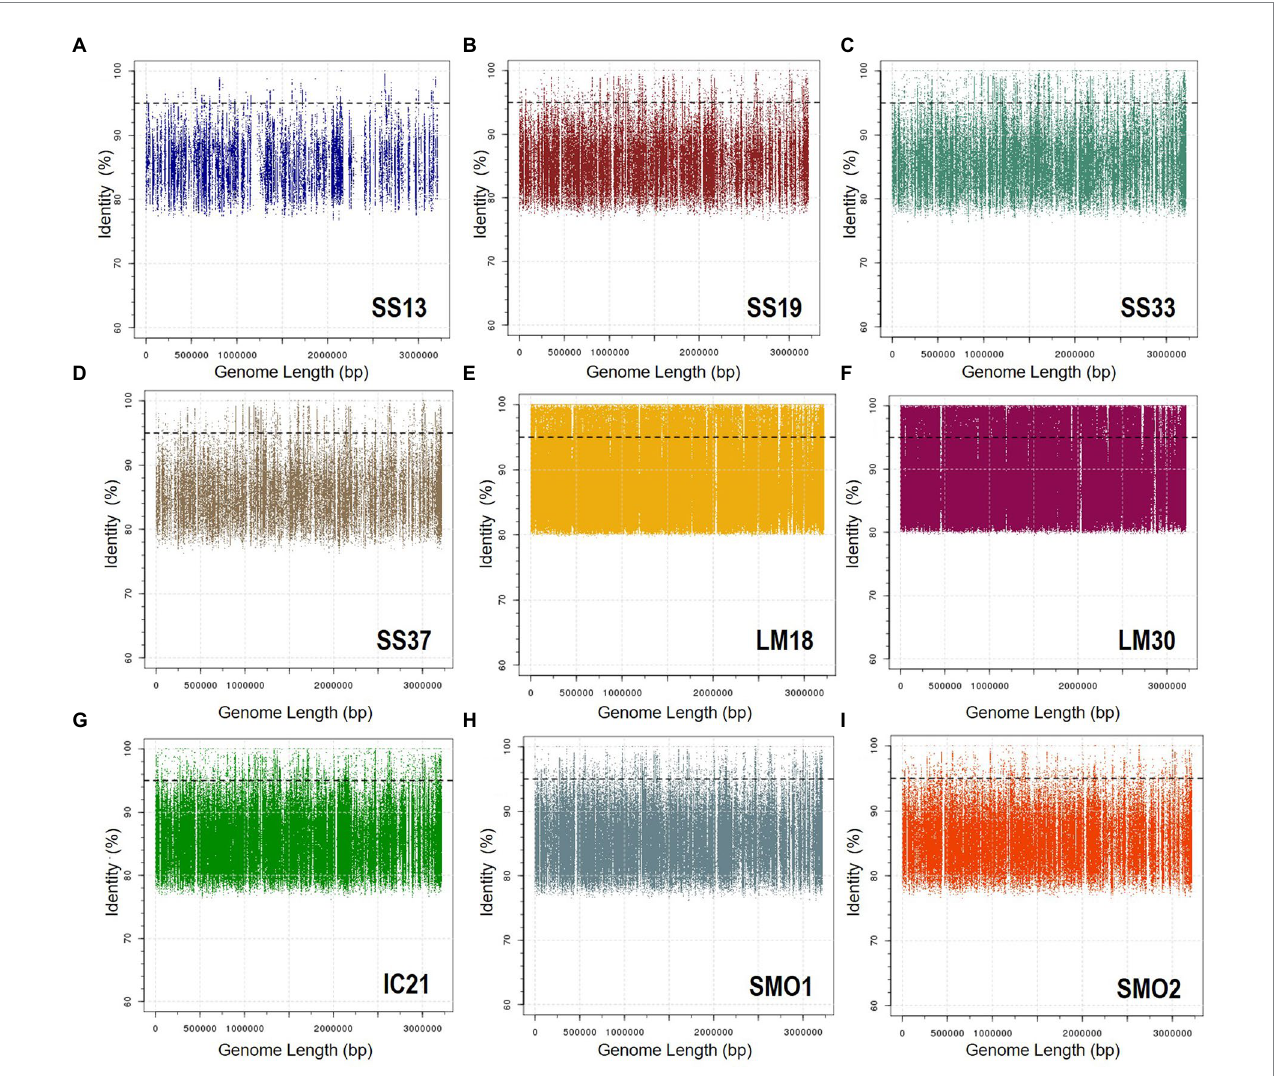
FIGURE 6 Recruitment plots of Natronomonas aquatica F2-12 T against different metagenomic datasets: (A) SS13, (B) SS19, (C) SS33, (D) SS37, (E) LM18, (F) LM30, (G) IC21, (H) SMO1, and (I) SMO2. In each panel the Y axis represents the identity percentage and X axis represents the genome length. The black dashed line shows the threshold for the presence of same species (95% identity). Abbreviations: SS13: metagenome from Santa Pola saltern (Spain) with 13% salinity (SRX328504; Fernández et al., 2014a), SS19: metagenome from Santa Pola saltern (Spain) with 19% salinity (SRX090228; Ghai et al., 2011), SS33: metagenome from Santa Pola saltern (Spain) with 33% salinity (SRX347883; Fernández et al., 2013), SS37: metagenome from Santa Pola saltern (Spain) with 37% salinity (SRX090229; Ghai et al., 2011), LM18: metagenome from Lake Meyghan (Iran) with 18% salinity (ERS1455390; Naghoni et al., 2017),